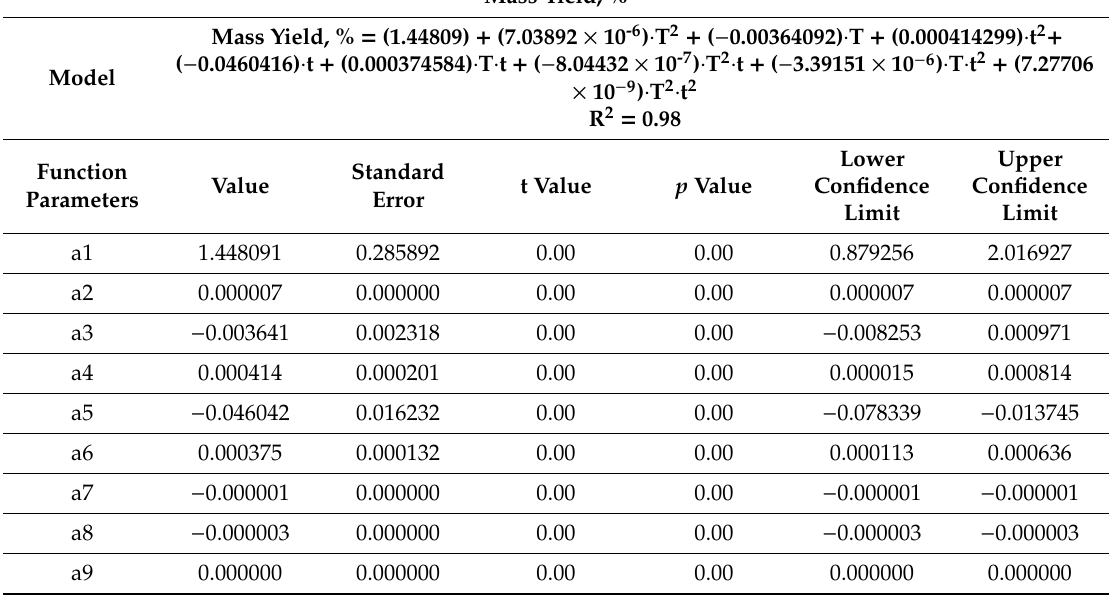
Table A1. The statistical parameters of polynomial regression analysis of the influence of SS torrefaction temperature and residence time on process mass